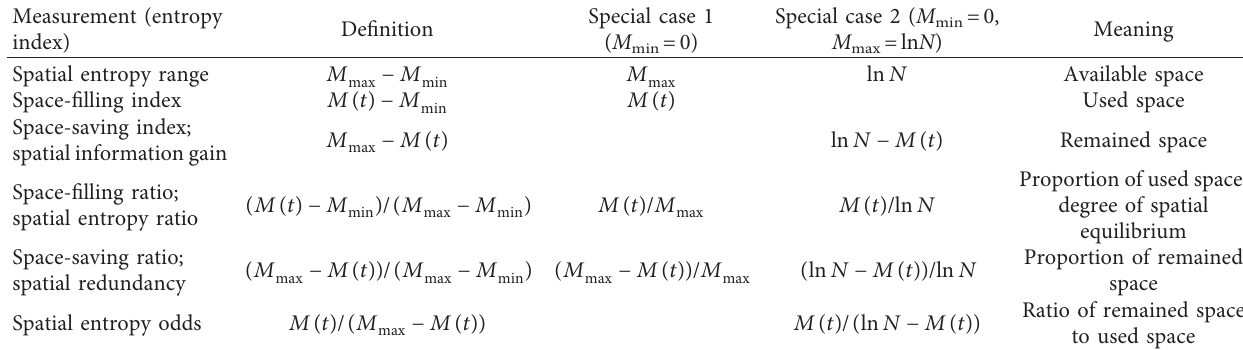
Table 2: A set of spatial measurements based on the entropy of urban growth and